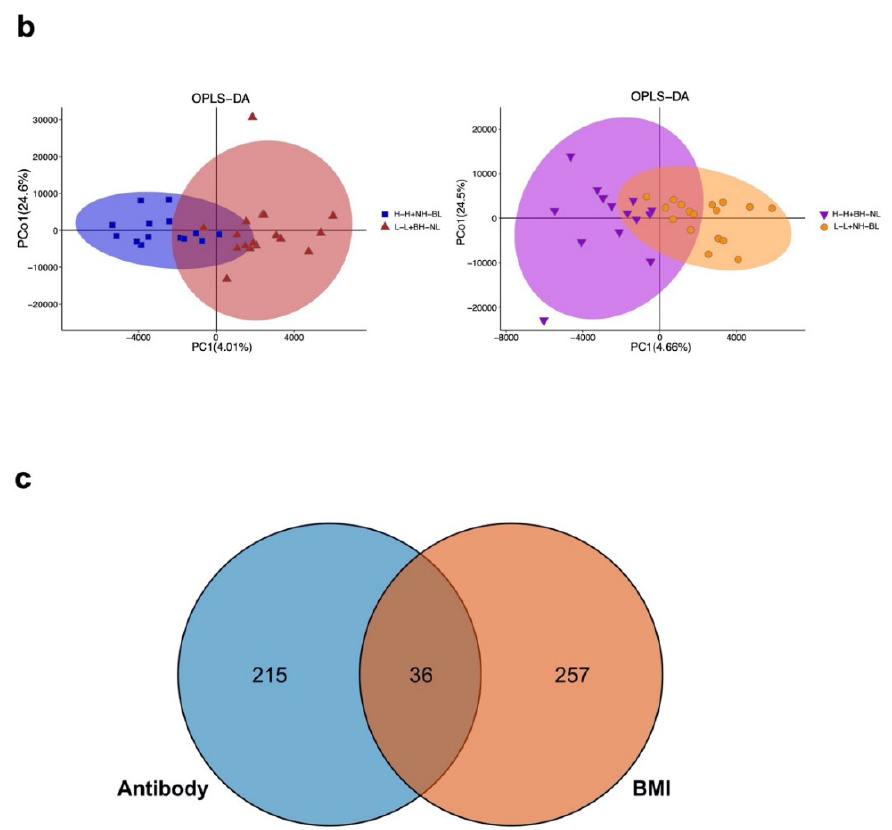
Figure 2. LC–MS study design and metabolite distribution. ( a ) The study design and flowchart